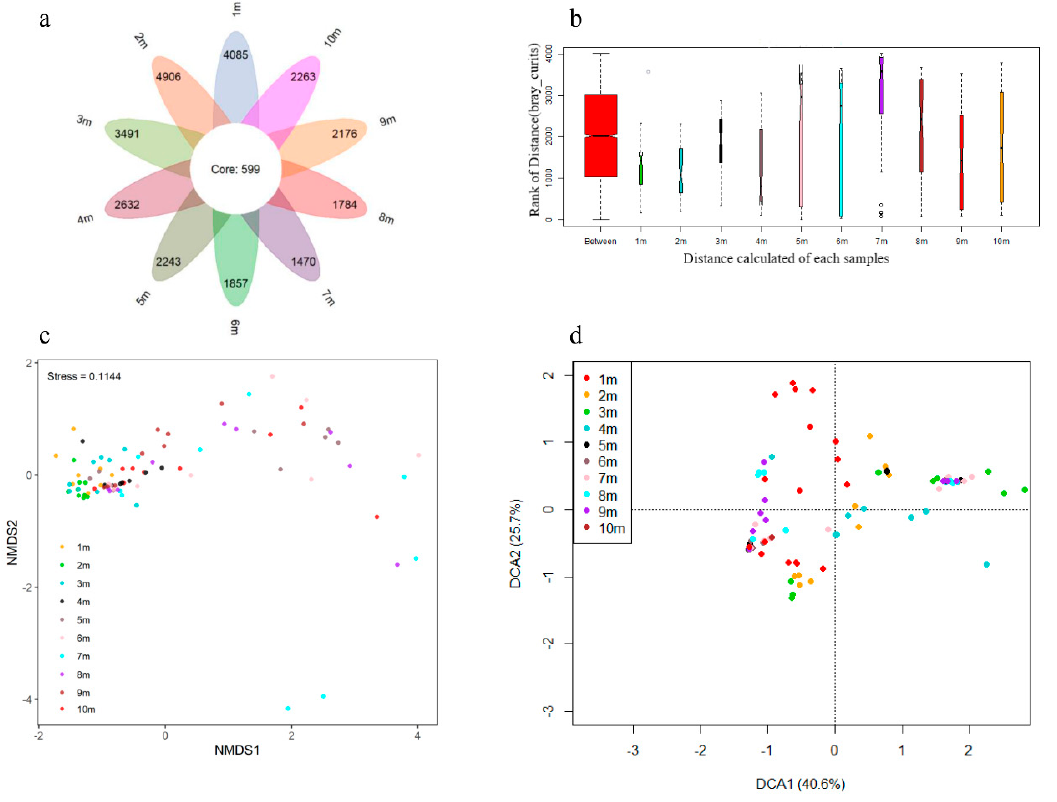
Figure 5. Venn diagram ( a ), Analysis of Similarities (ANOSIM) ( b ), Non-metric Multidimensional Scaling (NMDS) ( c ), and Detrended Correspondence Analysis (DCA) ( d ) analysis in OUT among ten depth layers of soil.